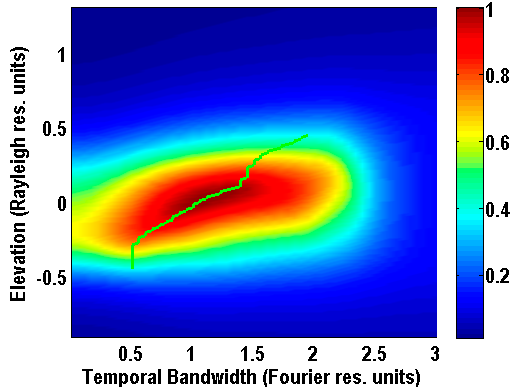
Figure 2. Gen. Capon 4D Diff-Tomo elevation-bandwidth functional, simulated data, output power; green plot shows fit temporal bandwidth.